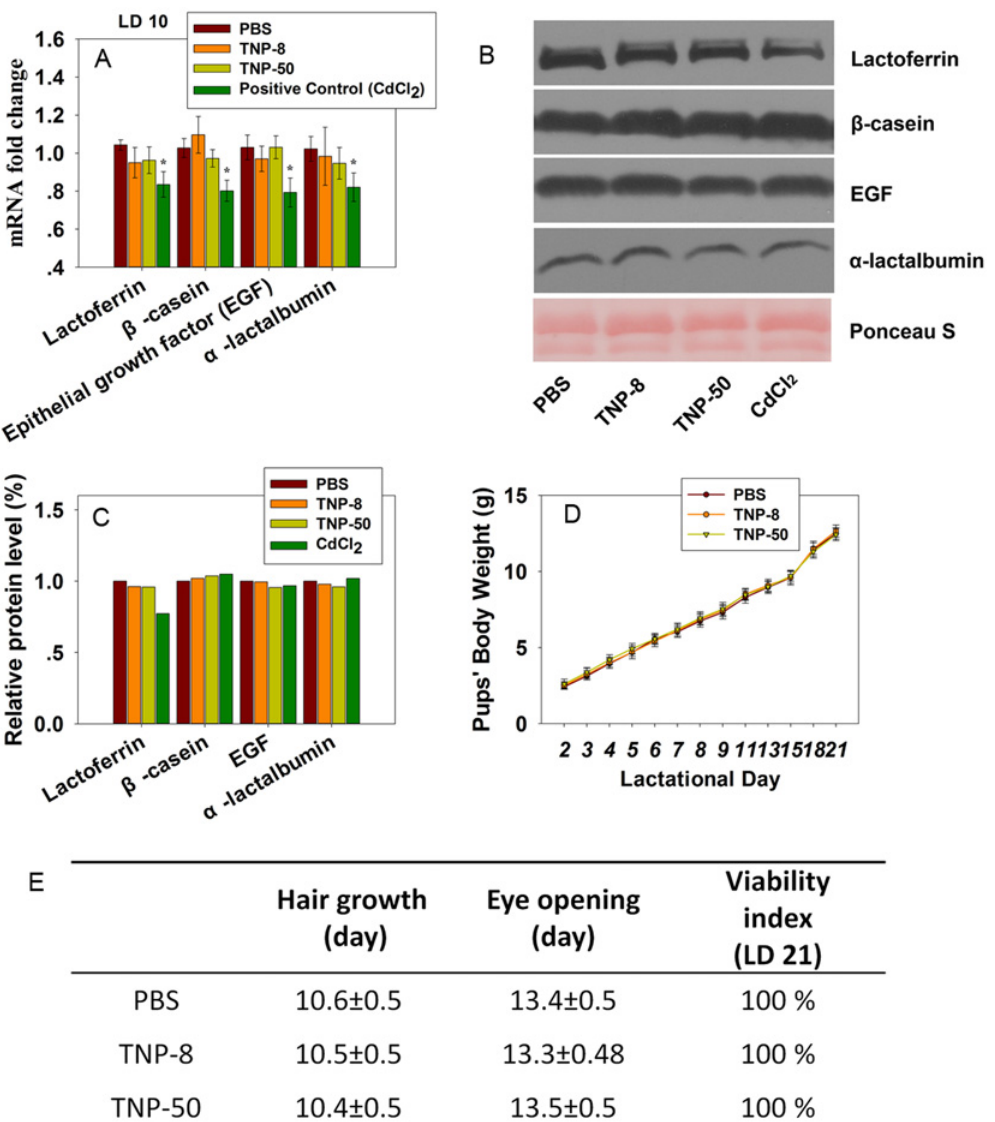
Fig 7. Analysis of nutrient quality of milk in the lactating dams (A, B and C) and effects of TNP exposures to dams on developmental landmarks of pups during lactation period (D, E). (A) The mRNA levels of β -casein, lactoferrin, α -lactalbumin and epidermal growth factor in mammary gland tissue were analyzed at LD 10 by quantitative PCR assay after dosing of TNPs at 8 mg/kg to dams. Data are mean ± sd. (n = 4) (B) Western blot of key milk proteins. (C) Bar graphs show relative levels of β -casein, lactoferrin, α -lactalbumin and epidermal growth factor by normalizing PBS group to 1.0. (D) Body weight gains of pups during the lactating period when dams were dosed with PBS, TNP-8 or TNP-50 (8 mg/kg BW) at LDs 2, 4, 6 and 8. (n = 7) (E) Effects of TNP treatments on key developmental landmarks of pups during lactation period. The symbol * represents significant difference from the PBS group (P <